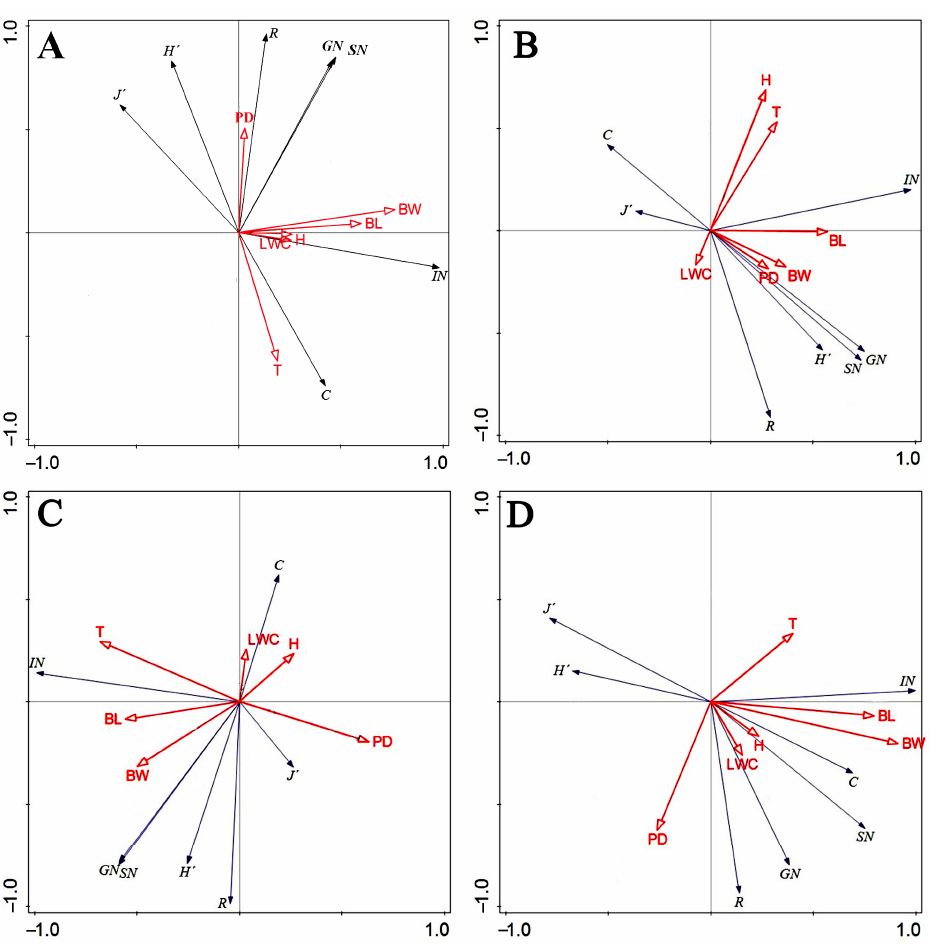
Figure 9. Redundancy analysis between species diversity of typhlocybinae and environmental factors in different study areas (( A ): study area; ( B ): Huajiang; ( C ): Bijie; ( D ): Shibing).